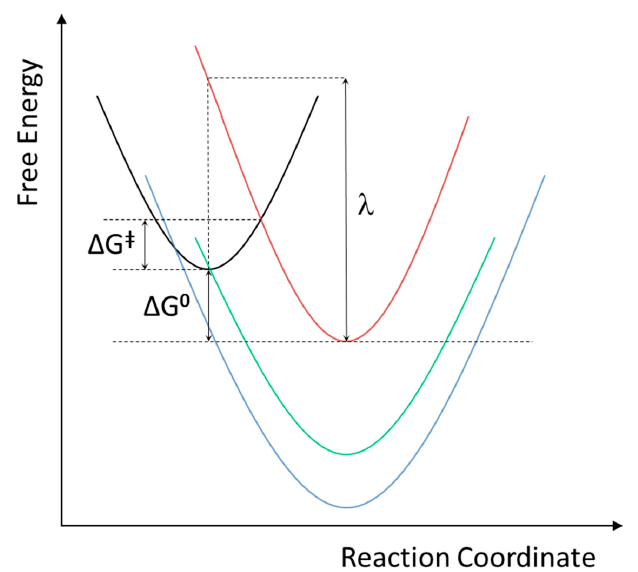
Figure 2. Schematic representation of the cases involved in Marcus theory. Red line = common reaction. Green line = barrierless reaction. Blue line = Marcus inversion region.